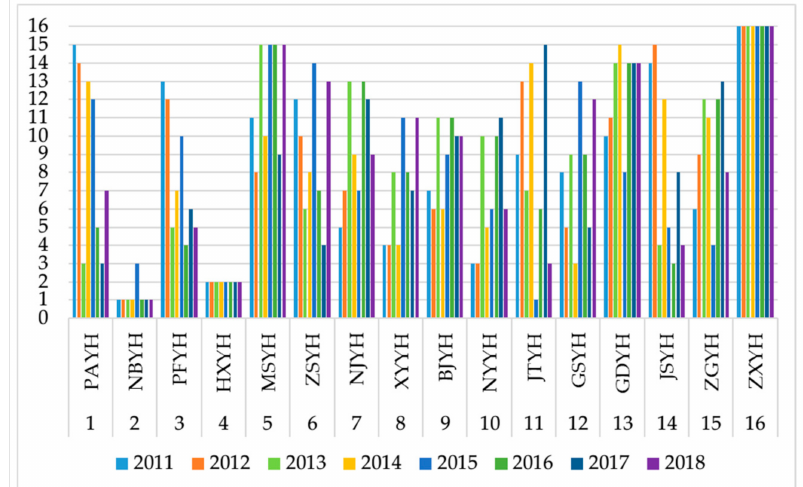
Figure 14. Rankings of dynamic ∆ CoVaR (The left axis refers to the ranking of each bank in terms of ∆ CoVaR (the di ff erence between the Conditional Value at Risk (CoVaRs) when the bank is in distress and in a normal state), based on the dynamic model which considers extreme circumstance and use a 1% quantile) (2011–2018, extreme circumstance).